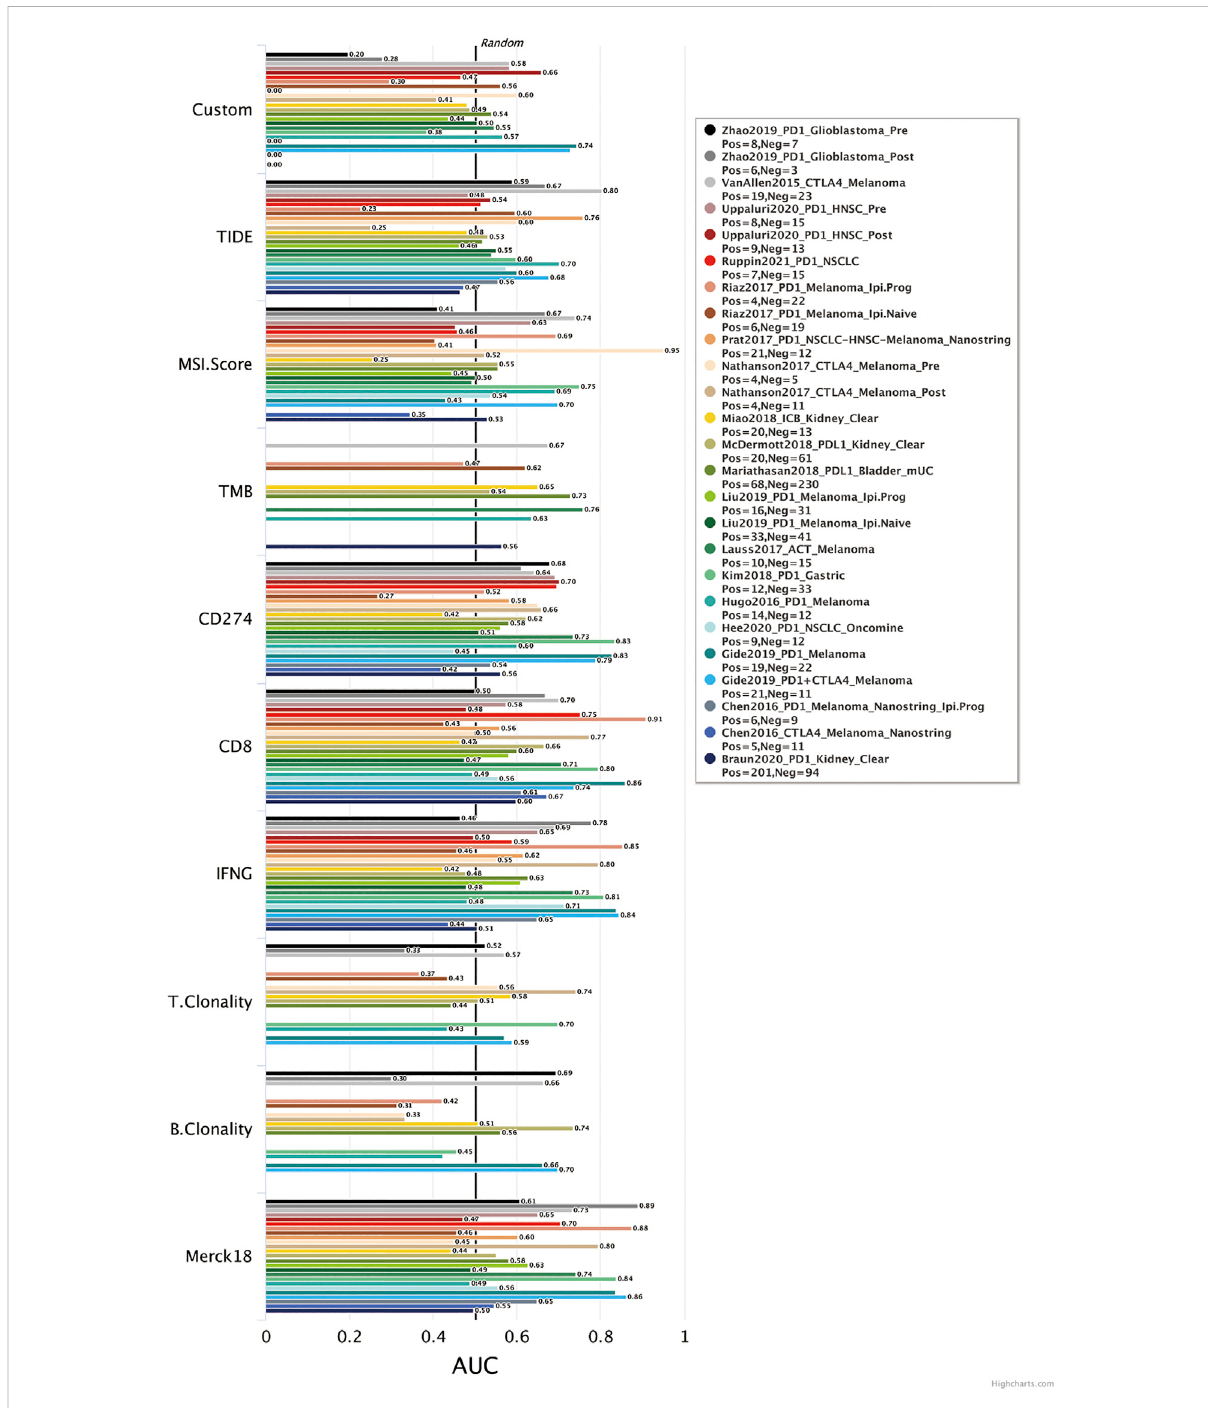
FIGURE 9 Biomarker evaluation from TIDE (Tumor Immune Dysfunction and